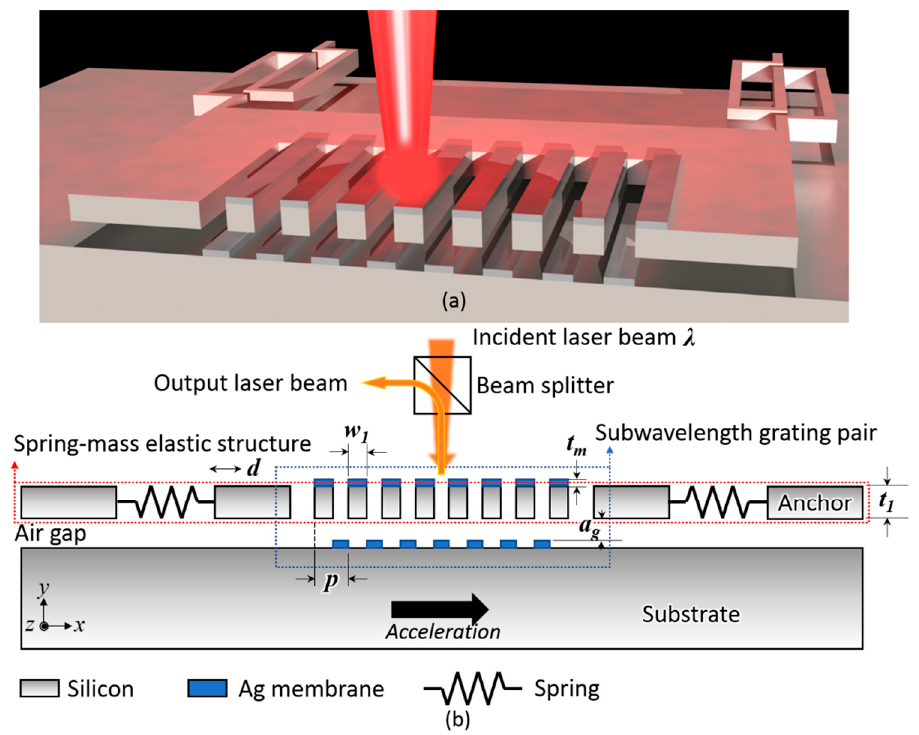
Figure 1. ( a ) Schematic diagram of the subwavelength grating pair-based optomechanical accelerometer along with; ( b ) its cross section view.